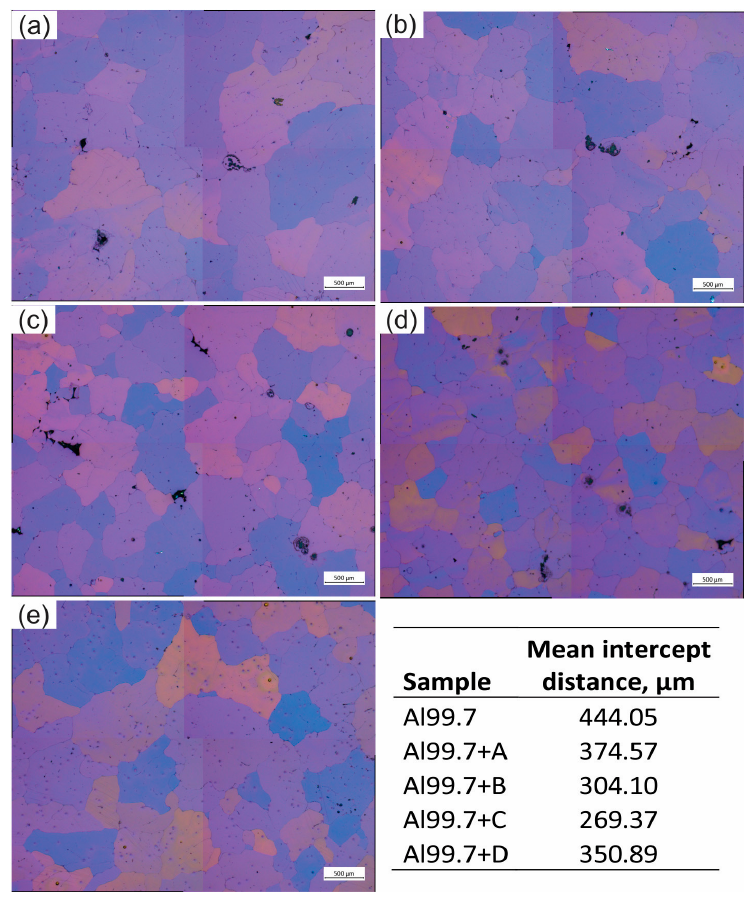
Figure 7. Micrographs taken in a polarized light for base aluminum alloy Al99.7 and grain-refined samples using grain refiner A ( b ), B ( c ), C ( d ), and D ( e ). Table in this figure is presenting the mean intercept distance in µm for micrographs presented in ( a – e ).